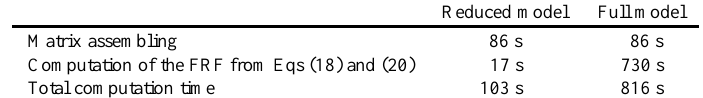
Table 4 Time to compute the FRF’s for the reduced and complete stiffened panel models